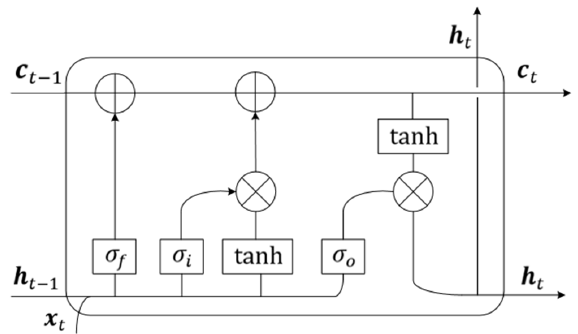
Figure 8. LSTM cell